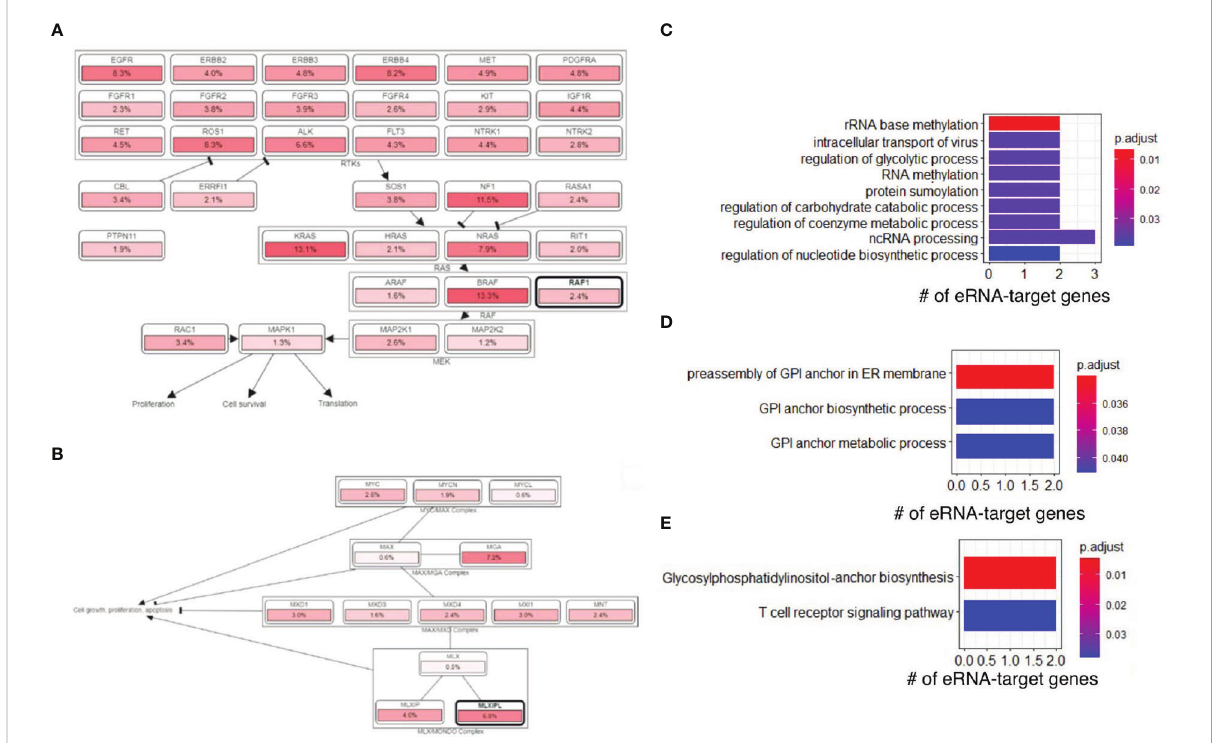
FIGURE 4 irAE-related genes were involved in oncogenic and other pathways. (A) The RAF1 and RTK-RAS signaling pathway. Pathway graphs were generated by using the cBioPortal website. (B) The MLXIPL and MYC signaling pathway. (C) GO enrichment of genes regulated by irAE- correlated enhancer ENSR00000326714. (D) GO enrichment of genes regulated by ORR-correlated enhancer ENSR00000164478. (E) KEGG pathway enrichment of genes regulated by ORR-correlated enhancer